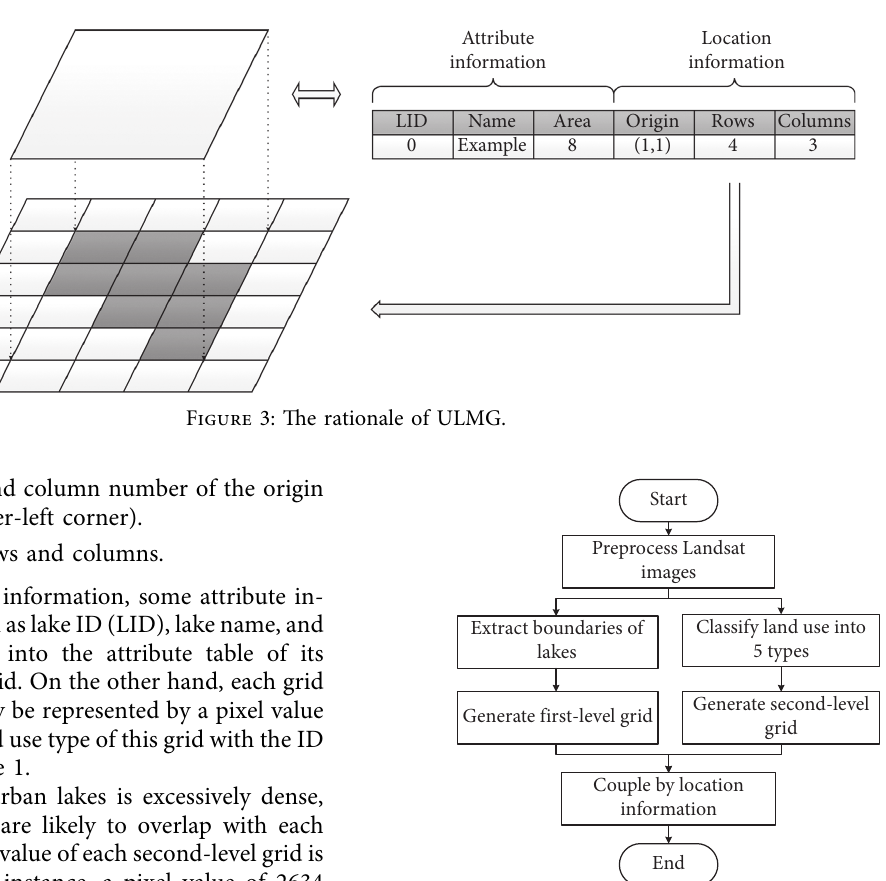
Figure 4: Generate ULMG from Landsat